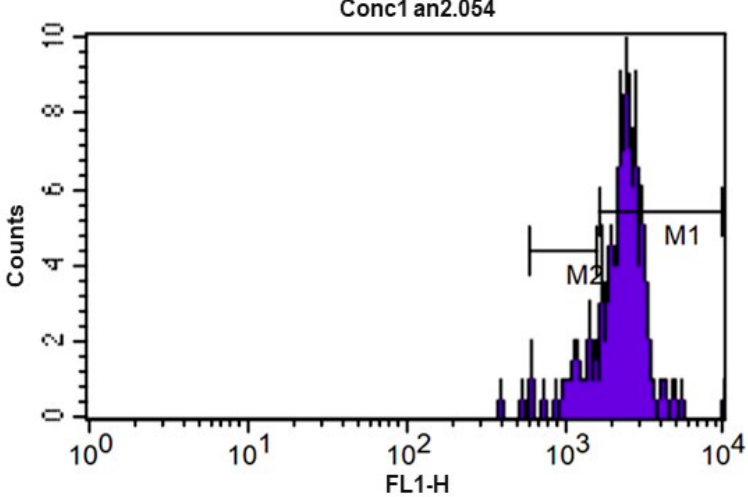
Figure 6. CFSE fluorescence histogram (carboxyfluorescein diacetate) of lymphocytes from equine peripheral blood after 72 h culture at 5% CO 2 and 37 °C without concavalin A. M1 and M2 represent the markers used to list the events of each division cycle that the software used for calculating the proliferation index. Table 7. The values represent the average and standard deviation of lymphoproliferation results performed with blood samples collected from animals in group II (16 to 30) at − 8 d, 0 d, +1 d, and +5 d. Statistical difference according to the Tukey–Kramer test—Beltsville, 2003. Group II